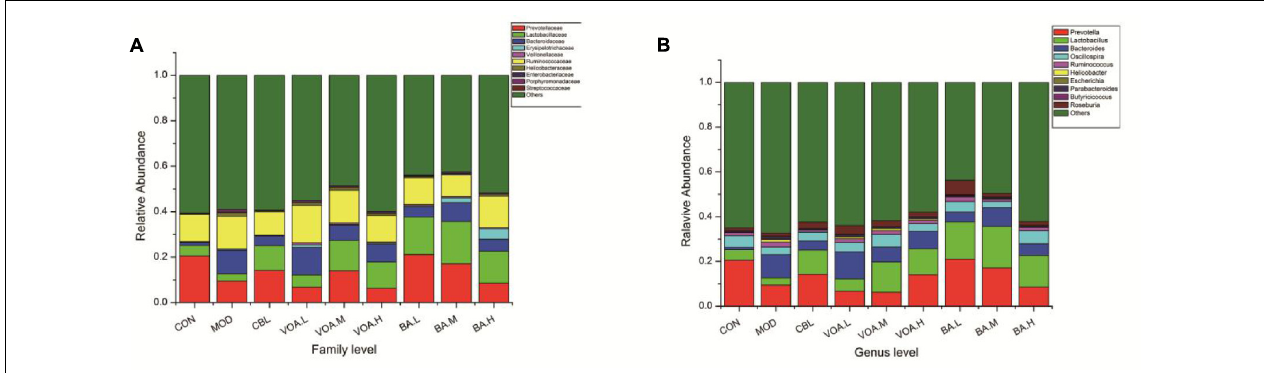
FIGURE 8 | Relative abundance of gut microbiota with respect to family (A) and genus (B) after 5-FU-induced intestinal mucositis.